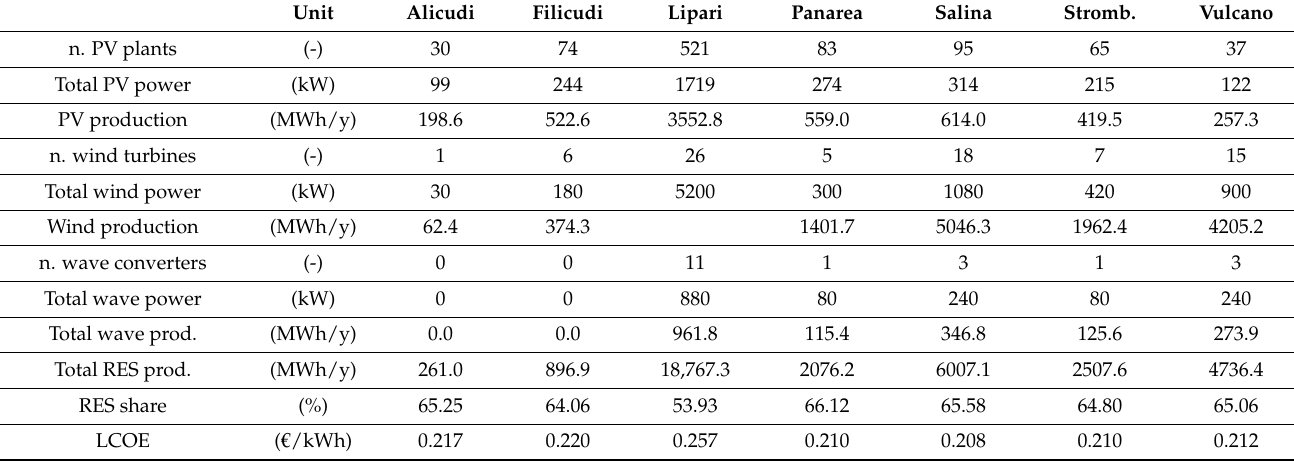
Table A9. Proposal of energy mix for the Aeolian